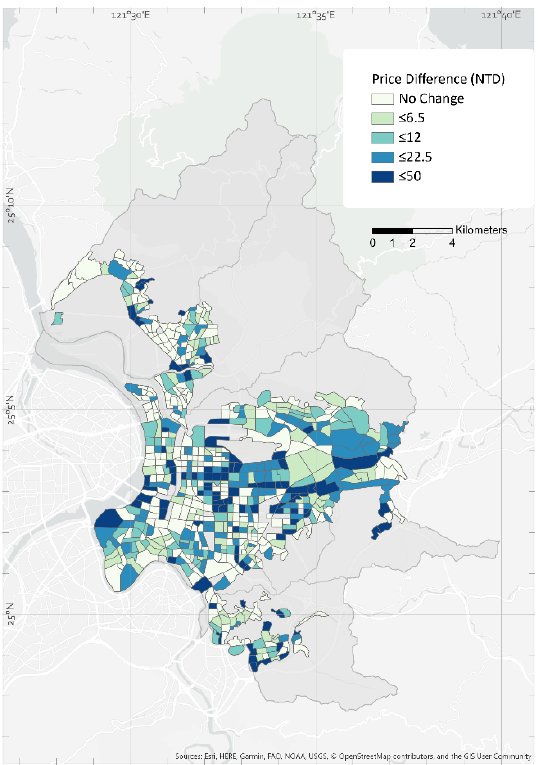
(a) Price Difference: showing the change of fee after the 2015policy change.